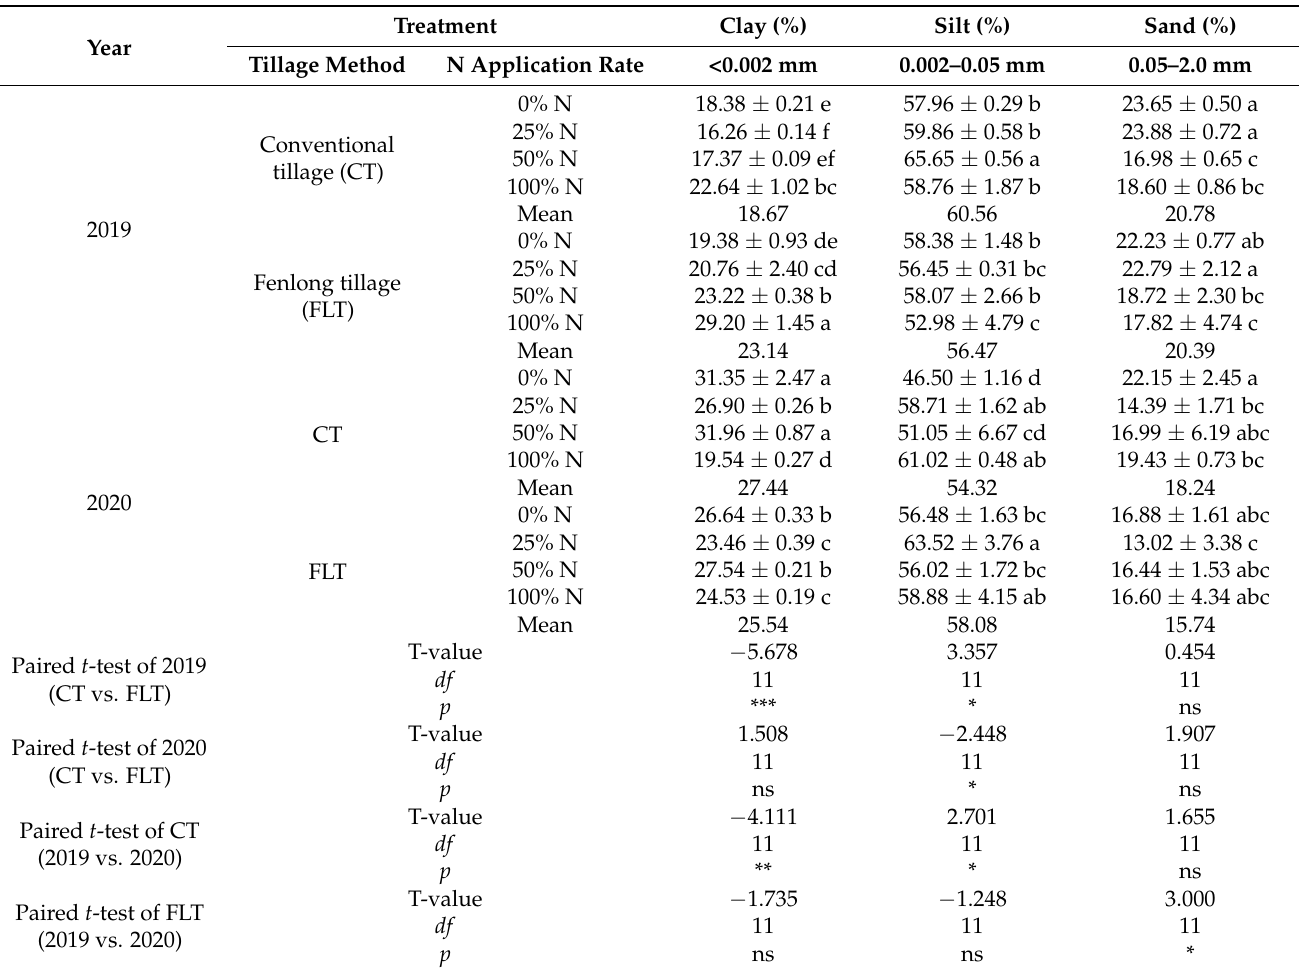
Table 1. Multiple comparisons and paired t -test of the cassava rhizosphere soil particle compositions under different